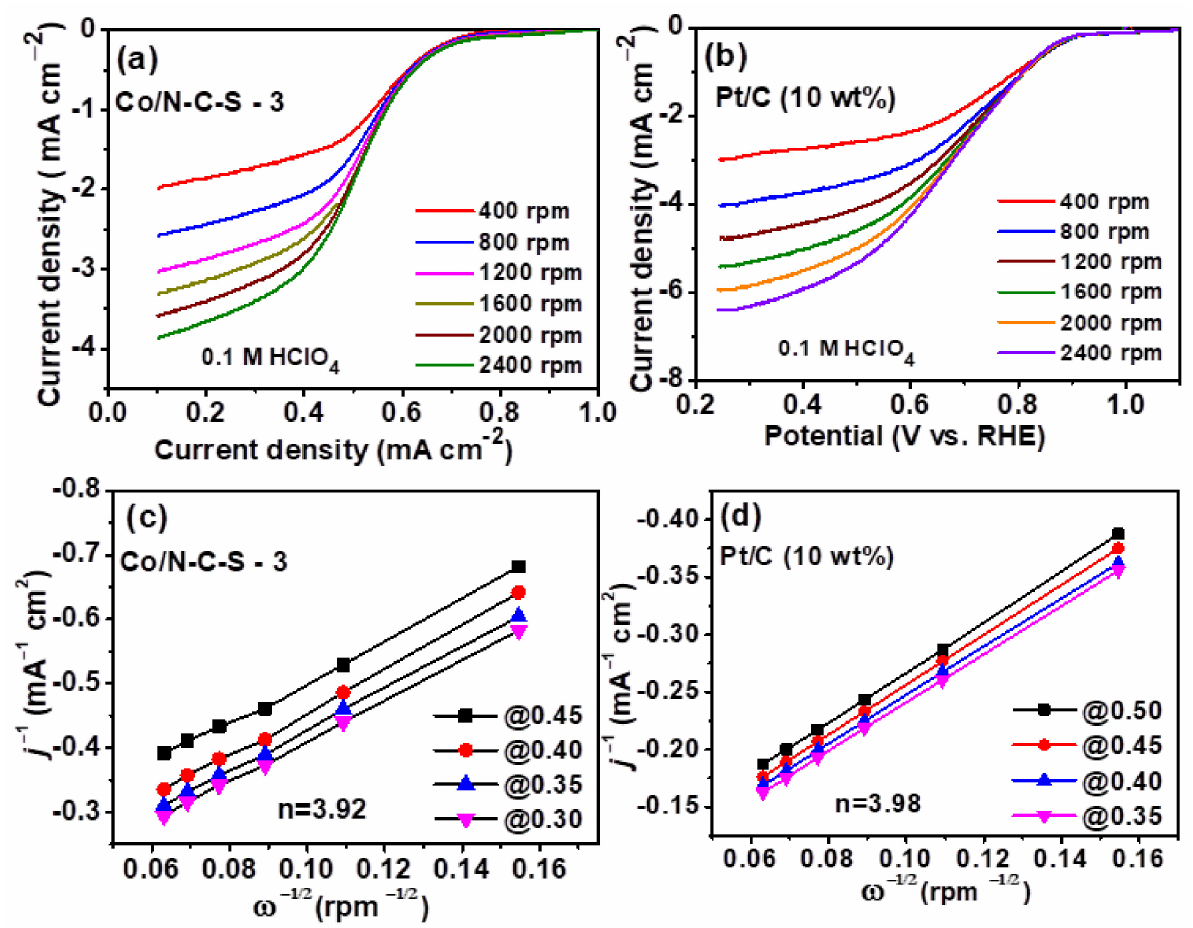
Figure 7. LSV curves of ( a ) Co/NSC-3 ( b ) Pt/C (10 wt.%) recorded at different rotation speeds and their respective K-L plots ( c , d ),